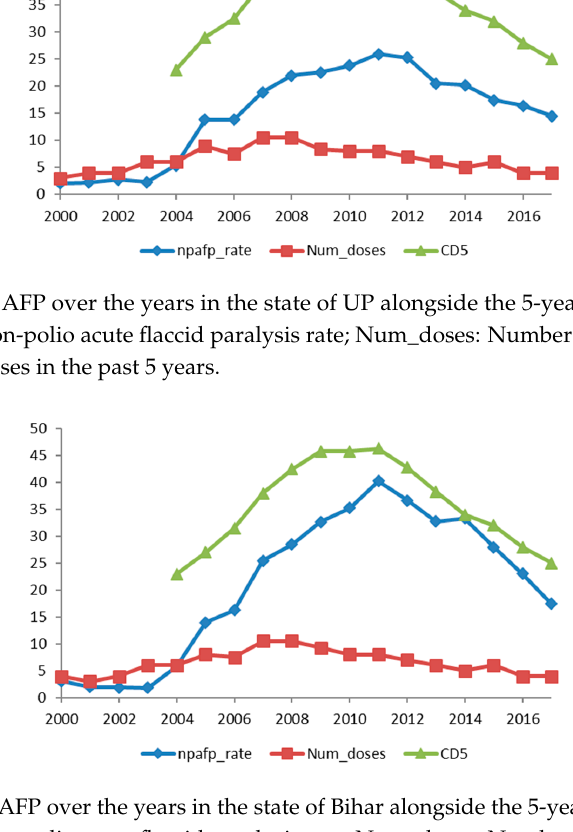
Figure 2. Non-polio AFP over the years in the state of Bihar alongside the 5-year cumulative doses of OPV. npafp_rate: Non-polio acute flaccid paralysis rate; Num_doses: Number of pulse polio rounds; CD5: Cumulative doses in the past 5 years. Table 2. Excess NPAFP in each year from